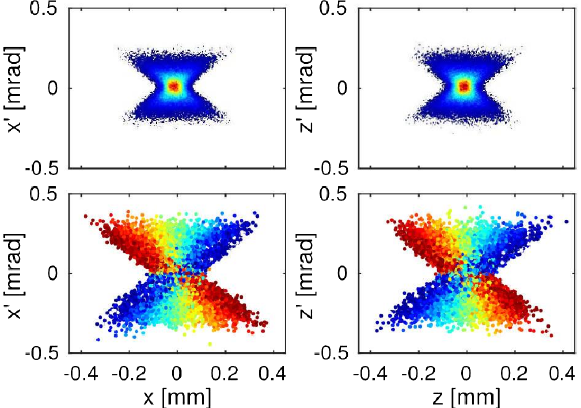
FIG. 2. (Left) Horizontal and (right) vertical phase-spaces at the undulator center. (Up) Density color map, ranging from red for higher to blue for lower densities. (Down) Energy color map, ranging from red for higher to blue for lower energies. Beam transport simulation in the nonlinear case with BETA and sympletic 6D tracking using the S2I-CM optics with r 11 ¼ r 33 ¼ 10 and r ¼ 0 . 4 mm. 56